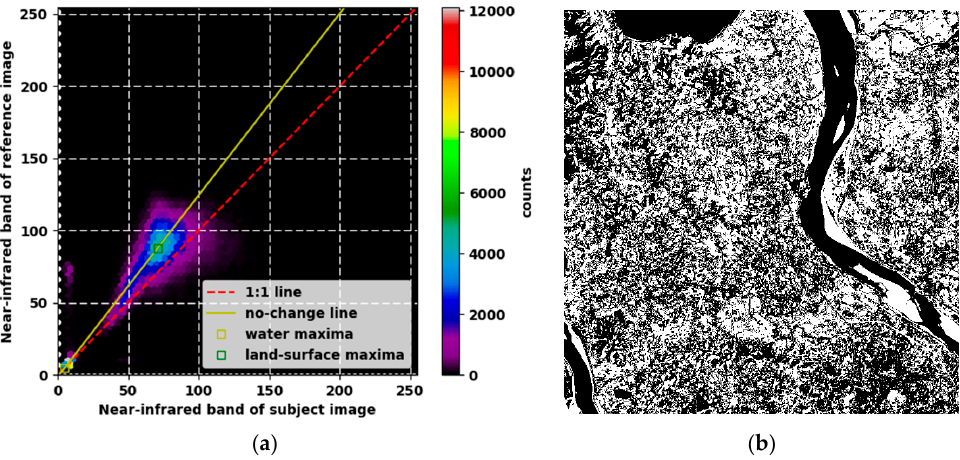
Figure 2. ( a ) Scattergram of near-infrared bands for subject image and reference image; and ( b ) the location of selected no-change regions.